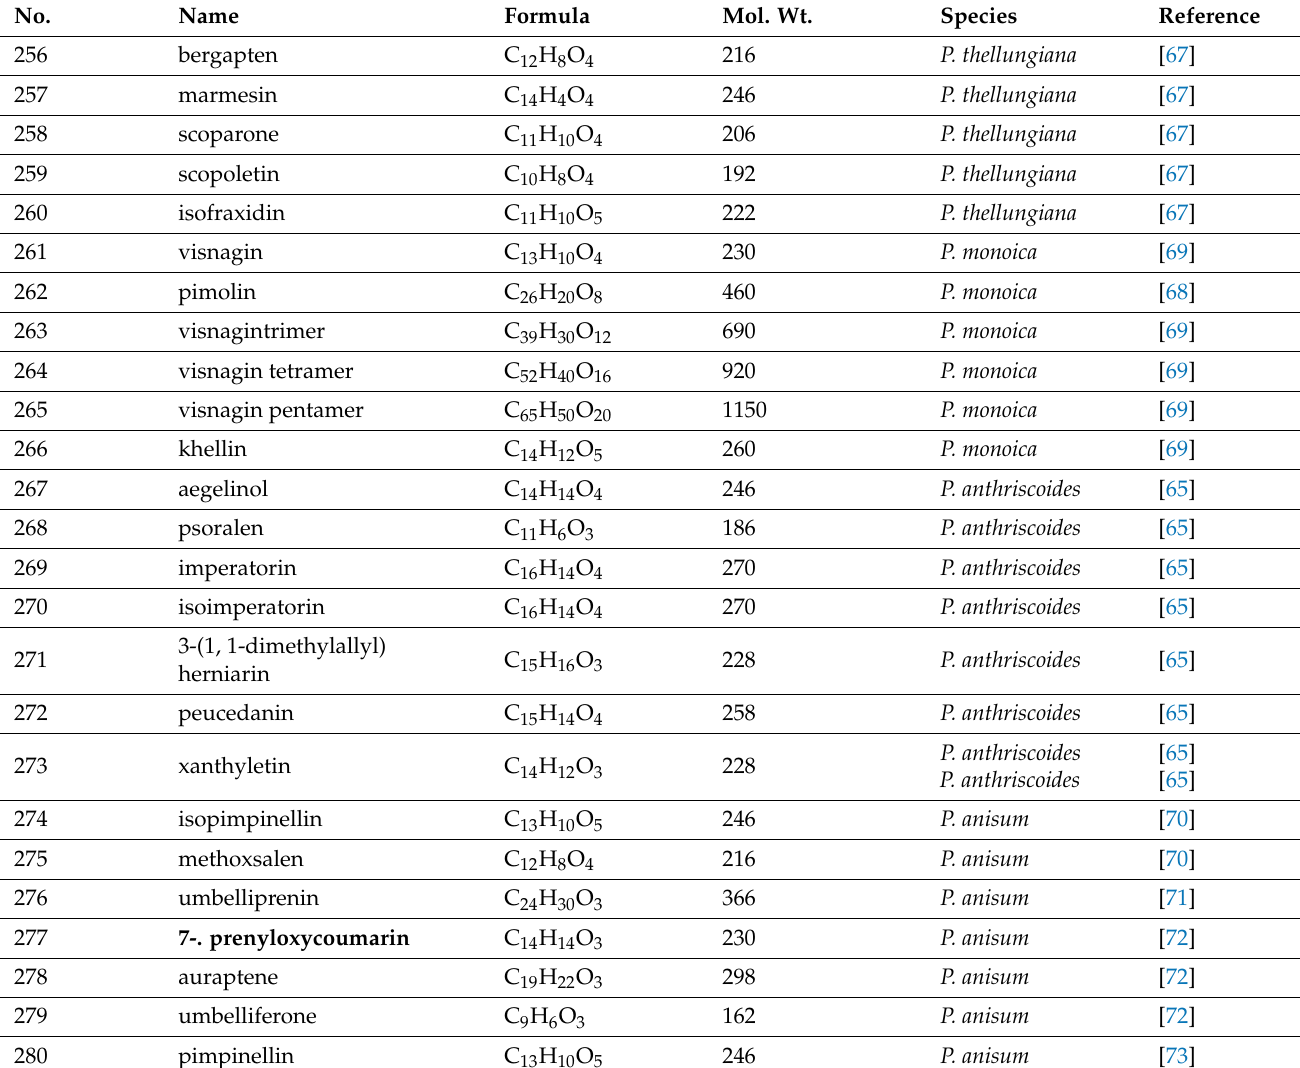
Table 5. Species of Pimpinella